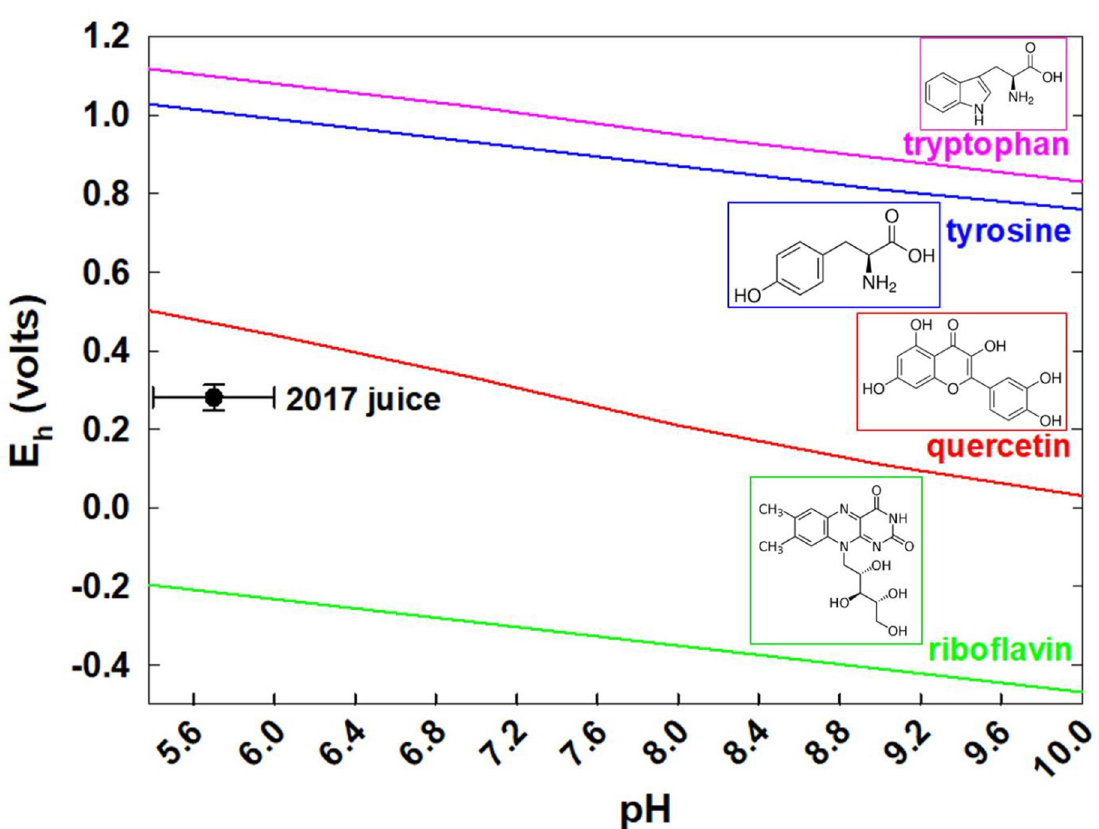
Fig 4. E h -pH diagram for one-electron oxidation/reduction of tryptophan (pink line), tyrosine (blue line) [32], quercetin (red line) [33], riboflavin (green line) [34], and sweet sorghum juice samples from 2017 planting year (black symbol) against the standard hydrogen electrode. Error bars for the 2017 juice represents mean ± s.d. for 173 samples in Table 2. Literature values were used for amino acids (in 0.2 M KCl, pH 13) [32], quercetin (in 0.5 M KCl; ethylene glycol as co-solute) [31, 33, 39], and riboflavin (in 0.1 M NaHCO 2 ) [34]. Literature E h -pH values were reported against NHE. Experimental E h value of juice samples could be converted to SHE scale by adding 200 ±